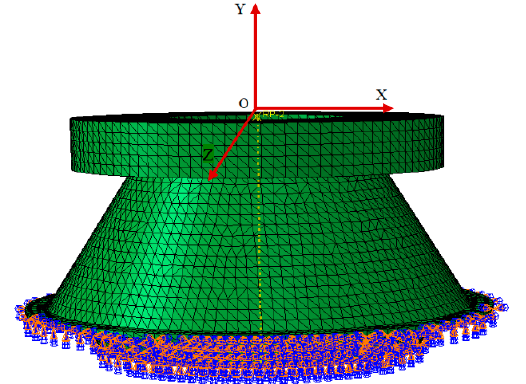
Figure 6. Finite element model of mounting main spring.